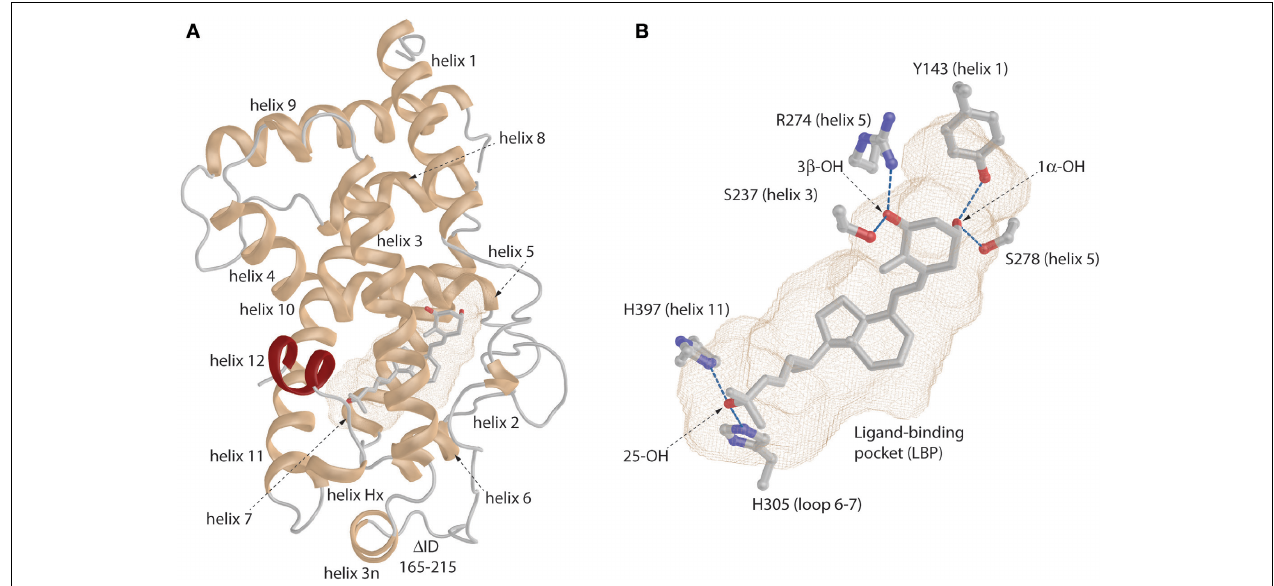
FIGURE 2 | General view of the VDR. (A) Ribbon representation of the VDR with annotated helices. The very last helix (helix 12) is highlighted in red color. (B) The binding mode of the 1,25D in the ligand-binding